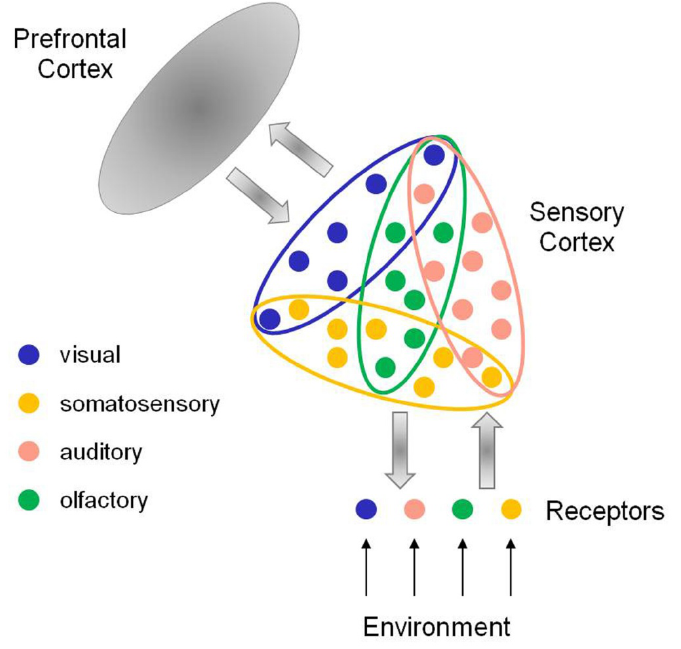
Figure 1. The prefrontal cortex receives and integrates signals from diverse sensory structures and pathways and controls information processing in, and interaction between, modal neural networks (visual, somatosensory, auditory, and olfactory) through down-stream signaling.